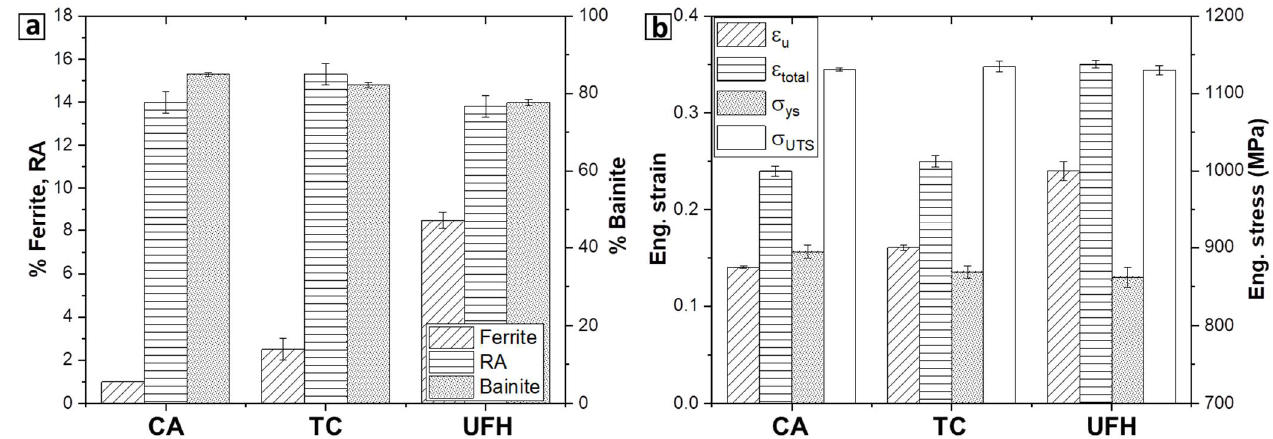
Figure 11. ( a ) Distribution of microconstituents in austempered samples (the amount of martensite is lower than 1% for all samples). RA: retained austenite. ( b ) Summary of the mechanical properties measured via uniaxial tensile testing. ε U : uniform elongation; ε total : total elongation; σ ys : 0.2% yield strength; σ UTS : ultimate tensile strength.